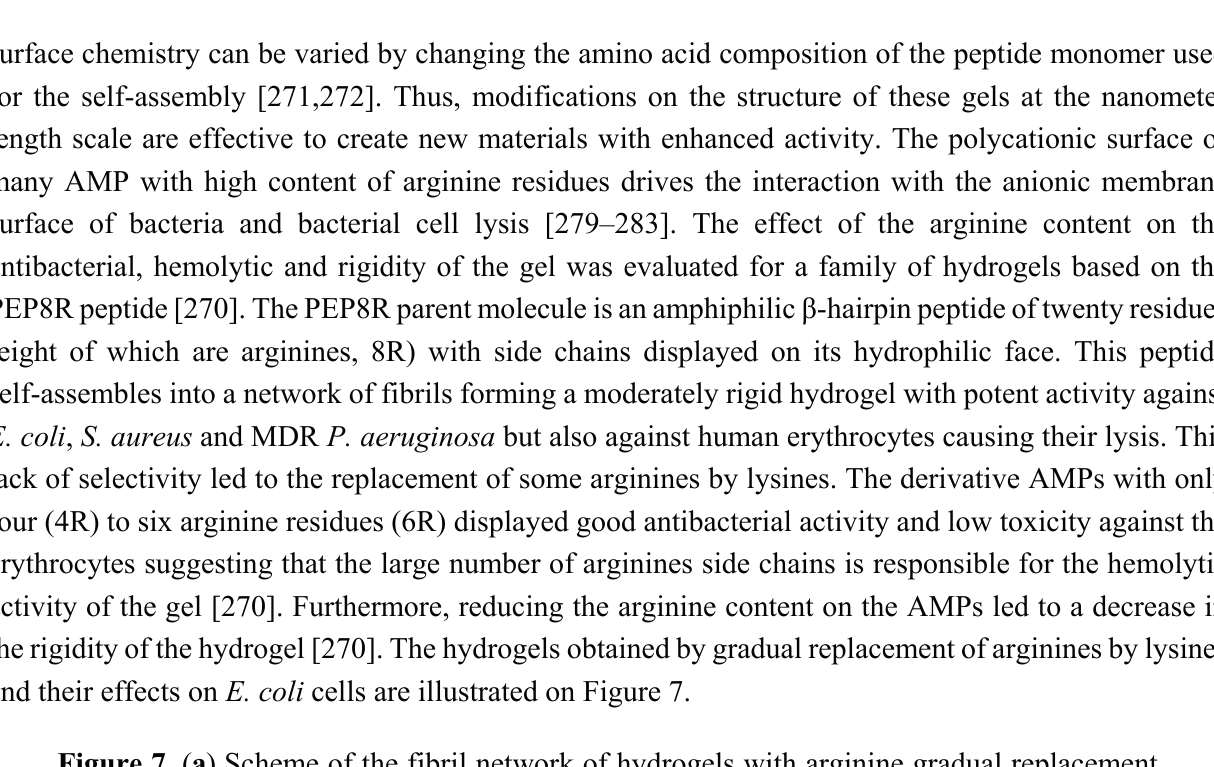
Figure 7. ( a ) Scheme of the fibril network of hydrogels with arginine gradual replacement by lysine; ( b ) The three-dimensional orthogonal projection images (derived from atomic force microscopy height data) of E. coli cells after 2 h interaction with PEP6R hydrogel surface ( left image) or control surface ( right image). Adapted with permission from [270], copyright 2012